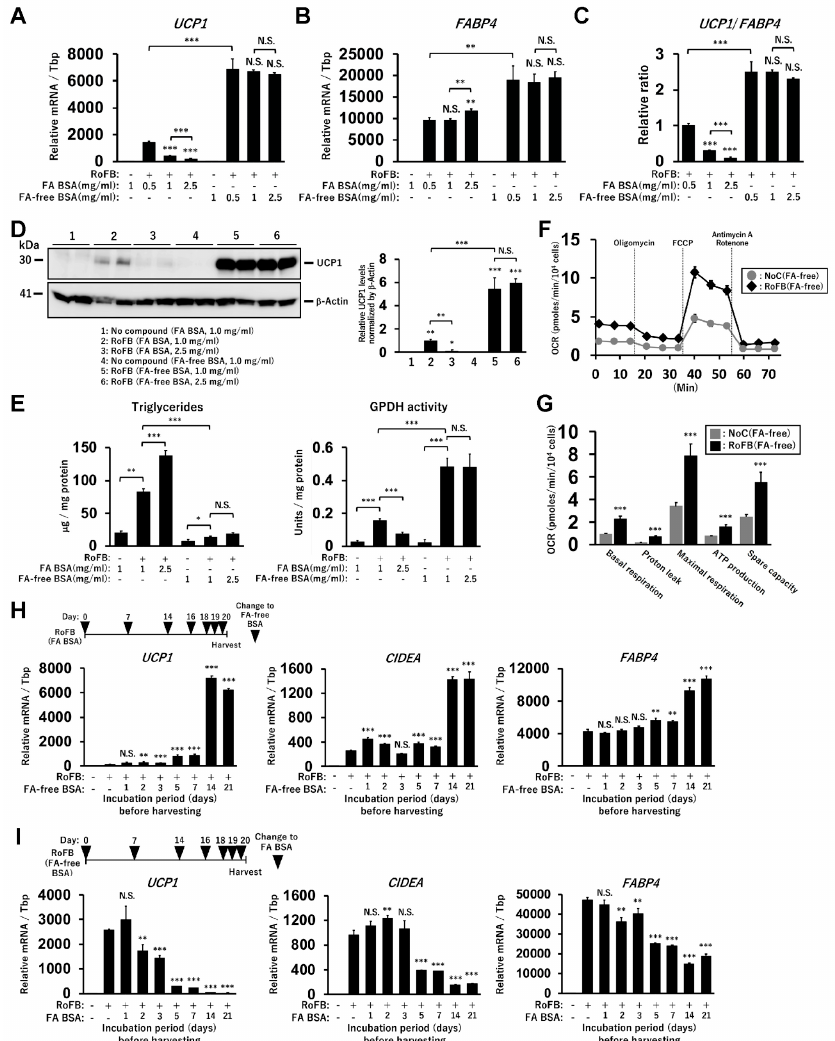
Figure 1. Induction of UCP1 expression in ciBAs converted under FA-free conditions. ( A , B ) The expression of UCP1 ( A ) and FABP4 ( B ) mRNA was quantified using qRT-PCR in ciBAs converted by different amounts of either FA-binding BSA (FA BSA) or FA-free BSA for 3 weeks. ( C ) The ratio of UCP1 to FABP4 expression was calculated to evaluate adipocyte browning. ( D ) UCP1 protein levels were quantified by immunoblotting. The band intensities were measured by densitometry using ImageJ software. ( E ) Cellular triglyceride content and glycerol-3-phosphate dehydrogenase 1 (GPDH) activity were measured in ciBAs. ( F ) Oxygen consumption rate (OCR) was measured in the control fibroblasts (grey circles) and ciBAs (black diamonds) converted under the FA-free condition using the flux analyzer. Oligomycin, FCCP, and antimycin A/Rotenone were added during the measurement as indicated. ( G ) Each OCR corresponding to basal respiration, proton leak, maximal respiration, ATP production, and spare respiratory capacity was calculated. ( H , I ) The expression of UCP1 , CIDEA , and FABP4 was measured in ciBAs treated with FA-free BSA or FA BSA for different incubation periods (days), before harvesting the cells on day 21. The timing of BSA replacement is shown in the illustration. Data represent mean ± SD ( n = 3). Student’s t -test: * p < 0.05, ** p < 0.01, *** p < 0.001, N.S.; not